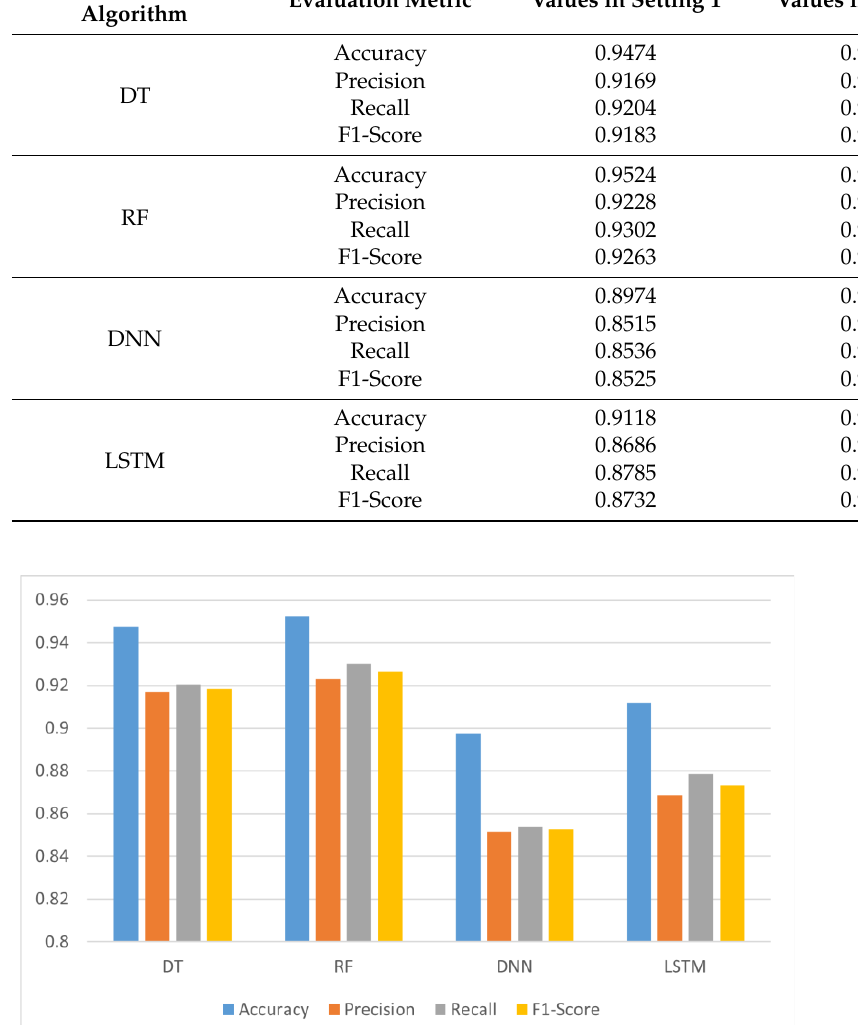
Figure 7. Values of the evaluation metrics for each candidate algorithm in setting 2.